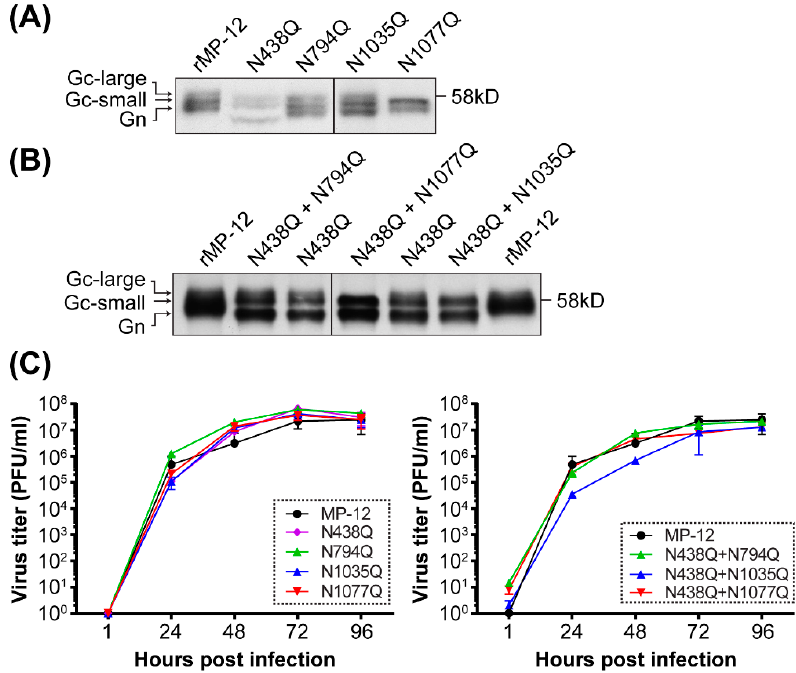
Figure 3. Generation of recombinant MP ‐ 12 encoding asparagine (N) ‐ to ‐ glutamine (Q) mutation(s) in Gn/Gc sequons. The Gn/Gc migration patterns of rMP ‐ 12, or that encoding N ‐ to ‐ Q mutation either in Gn or Gc (N438Q, N794Q, N1035Q, and N1077Q mutants) ( A ) or that encoding N ‐ to ‐ Q mutations both in Gn and Gc (N438Q/N794Q, N438Q/N1035Q, and N438Q/N1077Q mutants) ( B ). Vero E6 cells were infected with rMP ‐ 12 or the mutants at a multiplicity of infection (MOI) of 0.1 to 3, and metabolically labeled with [ 35 S] methionine/cysteine from 1 to 16 hours post infection (hpi). The cleared culture supernatants were subjected to immunoprecipitation using anti ‐ Rift Valley fever virus (RVFV) antibody. Precipitated virions were analyzed by 7.5% sodium dodecyl sulfate ‐ polyacrylamide gel electrophoresis (SDS ‐ PAGE) and autoradiography. Gc ‐ large: slow migrating Gc; Gc ‐ small: fast migrating Gc; ( C ) Virus growth kinetics in Vero cells. Vero cells were infected with indicated rMP ‐ 12 mutants at an MOI of 0.01. Virus titers were determined at 1, 24, 48, 72 and 96 hpi. Means +/ − standard deviations of three independent experiments are shown.